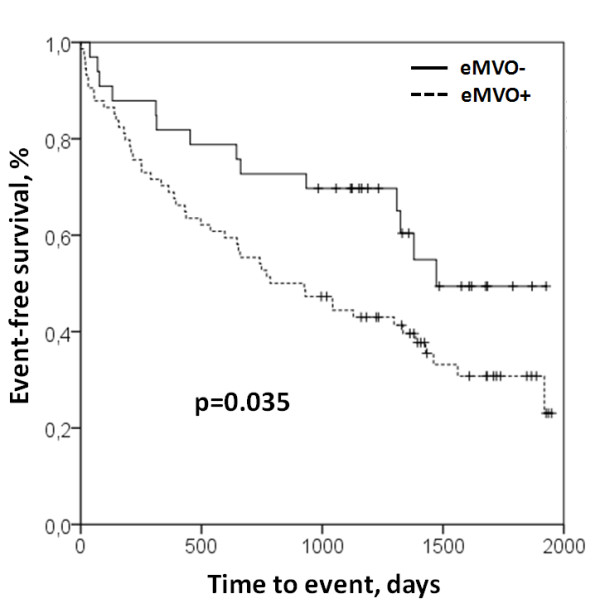
Kaplan-Meier curves showing the differences in event-free survival between patients without early MVO (eMVO-) and patients with early MVO (MVO-). MVO: microvascular obstruction.